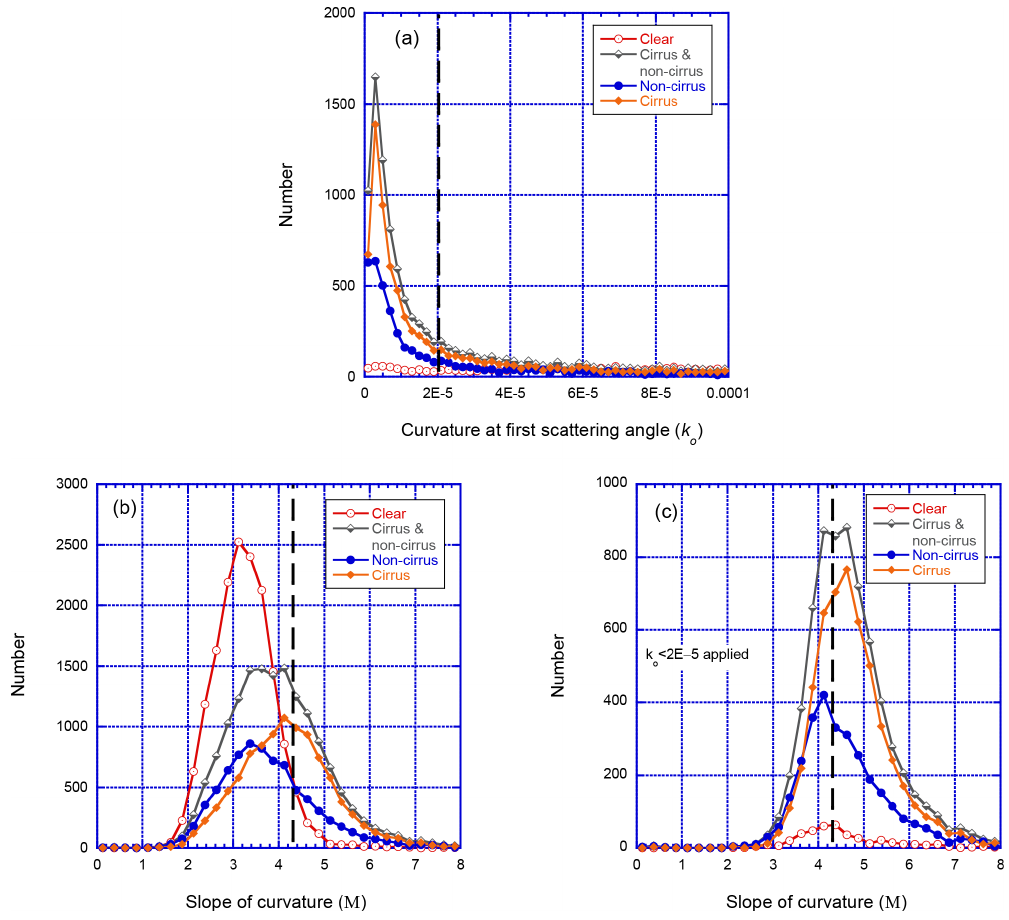
Figure 4. NASA Goddard Space Flight Center (GSFC; lat 38.99, long − 76.84) AERONET data coincident with MPLNET lidar-derived sky condition categories (clear, both cirrus and non-cirrus clouds, non-cirrus clouds, and cirrus clouds) from 2001 to 2013. The AERONET solar aureole 1020nm radiances are used to calculate the curvature at the first scattering angle ( k o ) and the slope of curvature ( M ) between 3.2 and 6.0 ◦ scattering angles. (a) The number distribution of k o is shown and the dashed vertical line at k o equal to 2 × 10 − 5 indicates the threshold at which values less than 2 × 10 − 5 are considered possibly cirrus cloud contaminated (the x axis is truncated at 1 × 10 − 4 for viewing purposes). (b) The number distribution of M is shown and M values greater than 4.3 are considered to be possibly cirrus cloud contaminated (the dashed vertical line indicates the threshold of 4.3). (c) Similar to (b) except that the k o threshold ( k o < 2 × 10 − 5 ) is applied first and, as a result, data greater than 4.3 in this panel are considered to be cirrus cloud